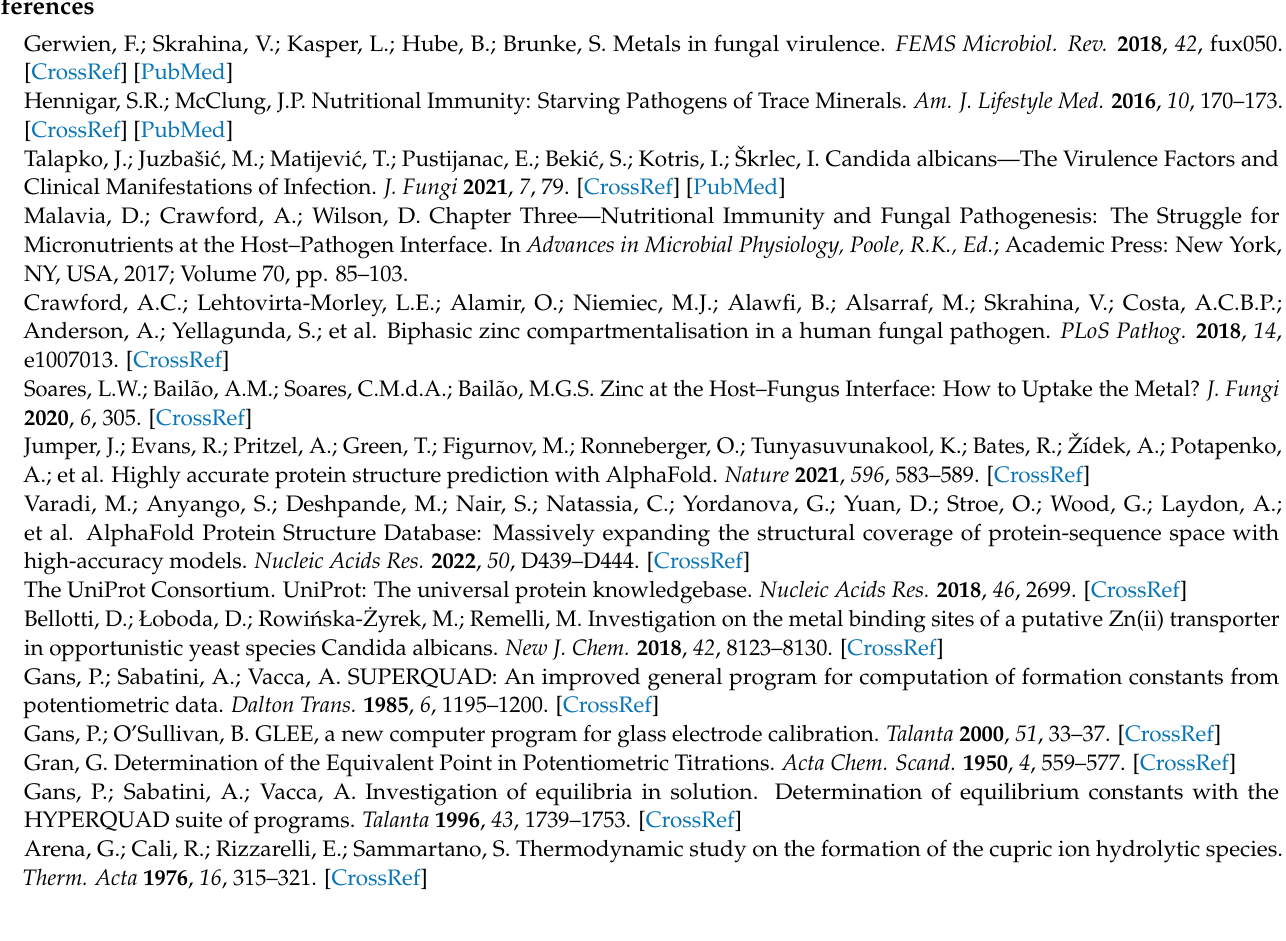
Figure S17: (a) ESI-MS spectrum for Cu 2+ /L2 system at L:M molar ratio=1:1 in MeOH:H 2 O (1:1) mixture solution, (b) comparison of experimental and simulated isotopic pattern of the chosen metal complex [CuH 3 L] 3+